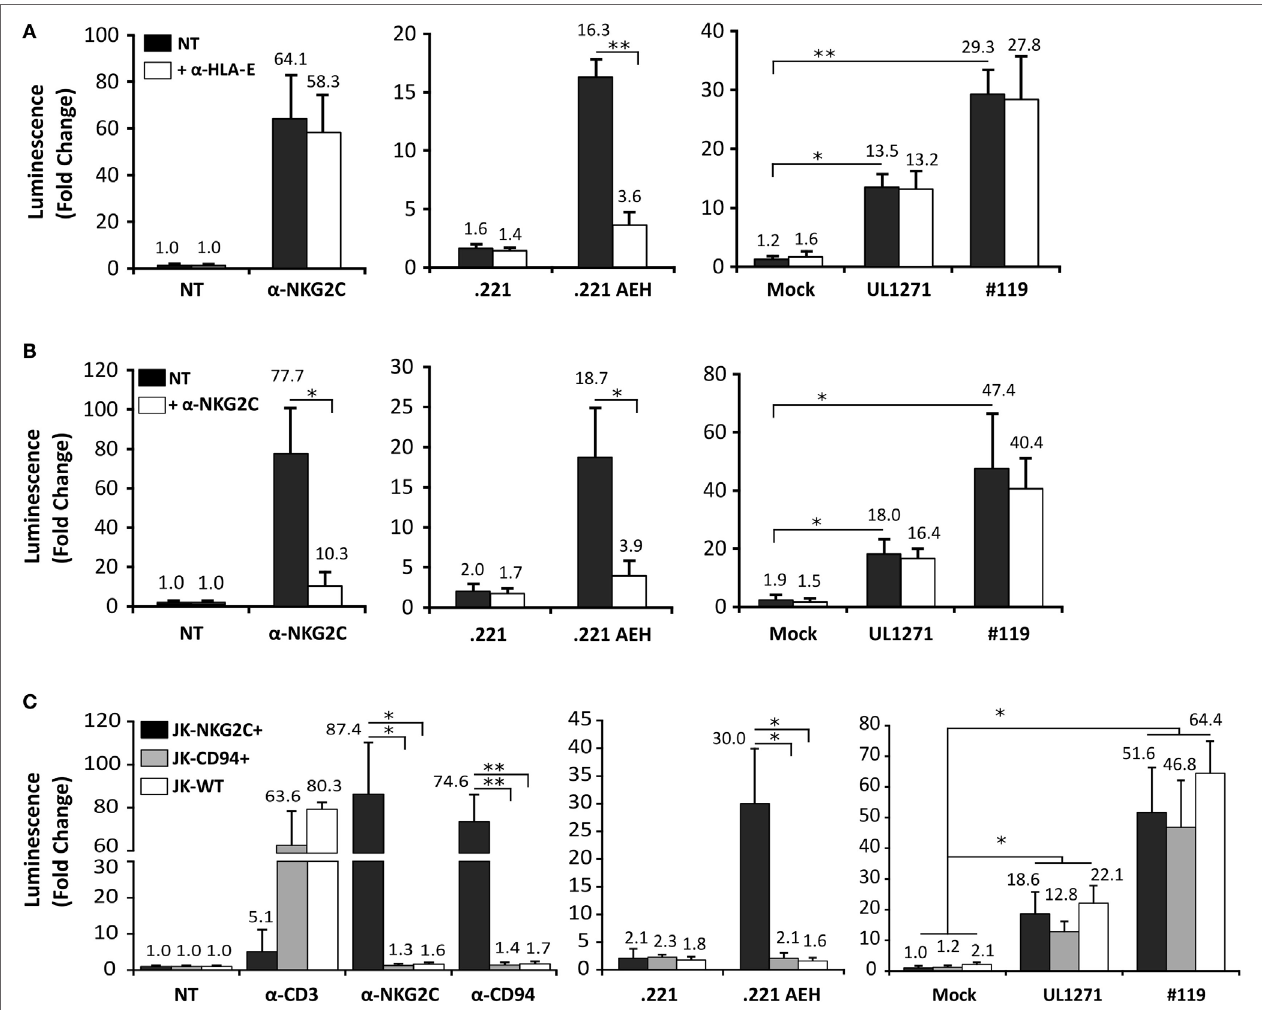
FigUre 6 | Jurkat-NKG2C + activation by cells infected with human cytomegalovirus (HCMV) clinical isolates is independent of the CD94/NKG2C receptor. (a) Response of Jurkat-NKG2C + reporter to HFFF infected by HCMV clinical isolates or .221-AEH cells preincubated with the 3D12 anti-HLA-E monoclonal antibody (mAb) (5 µg/ml). (B) The blocking effect of an anti-NKG2C mAb (clone MAB1381) (5 µg/ml) on the response of Jurkat-NKG2C + cells to stimulation with either plate-bound anti-NKG2C mAb, .221-AEH cells or HFFF infected by HCMV clinical isolates (white bars) was assessed in parallel. Data correspond to three independent experiments (mean ± SD); the average infection rate for each experiment was > 50%. (c) Jurkat-NKG2C + (black bars), Jurkat-CD94 + (gray bars), and wild-type Jurkat (WT) (white bars) were stimulated with 1 µg/ml of plate-bound anti-CD3, -NKG2C, -CD94 mAbs, or cocultured with .221 or .221-AEH cells (negative and positive controls). Confluent HFFF cells infected with UL1271 and #119 clinical isolates (multiplicity of infection = 10) for 72 h were cocultured with the different Jurkat cell lines (NKG2C + , CD94 + , and WT) previously electroporated with the reporter plasmid. Data correspond to three independent experiments (mean ± SD); the average infection rate for each experiment was > 50%. Statistically significant differences are indicated (* p < 0.05; ** p <